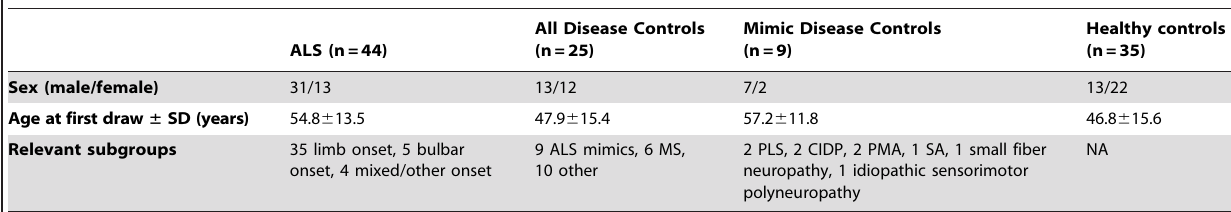
Table 1. Clinical characteristics of all study participants.